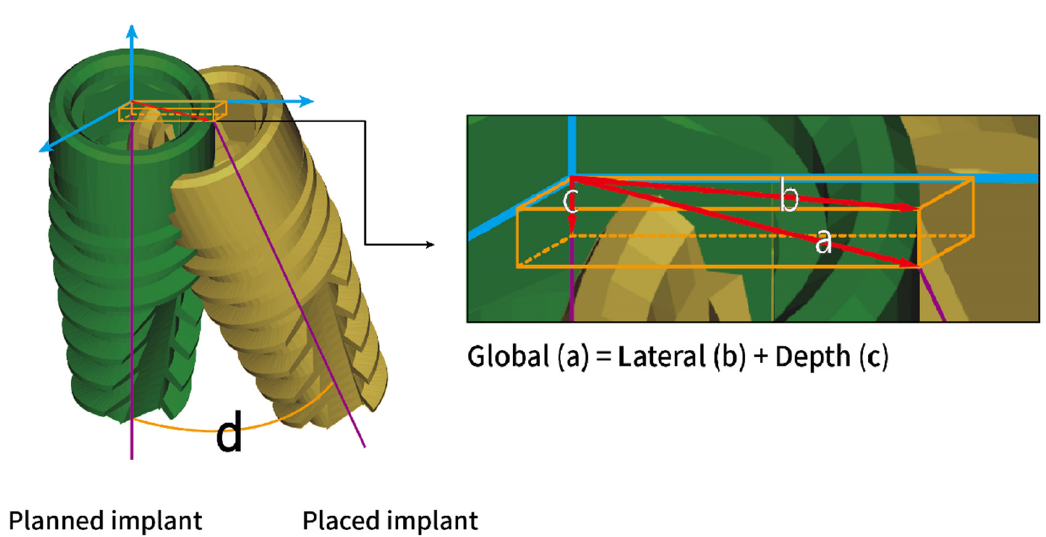
Figure 4. On the basis of the coordinate system created according to the planned implant position (blue arrows), the following spatial deviations (red arrows) and angular deviation between planned and placed implants were defined and measured: ( a ) global deviation, ( b ) lateral deviation, ( c ) depth deviation, and ( d ) angular deviation.